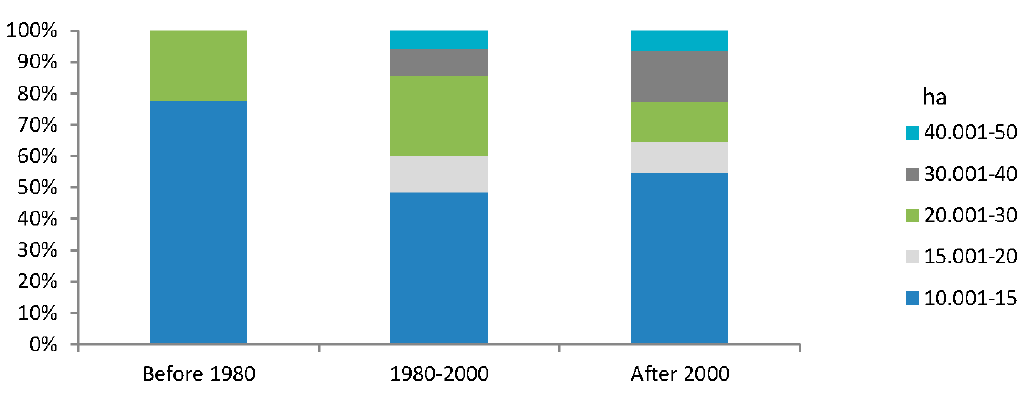
Figure 8. Increasing size of medium-scale landholdings in Mchinji, Kasungu, and Lilongwe ( N = 91).